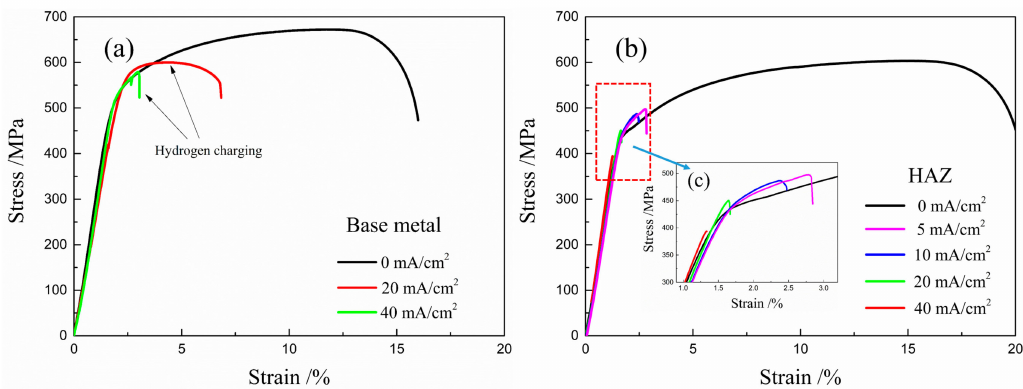
Figure 5. Stress-strain curves for the X80 steel: ( a ) the base metal samples and ( b ) the HAZ samples tested during hydrogen charging at di ff erent current densities of 0, 5, 10, 20, and 40 mA / cm 2